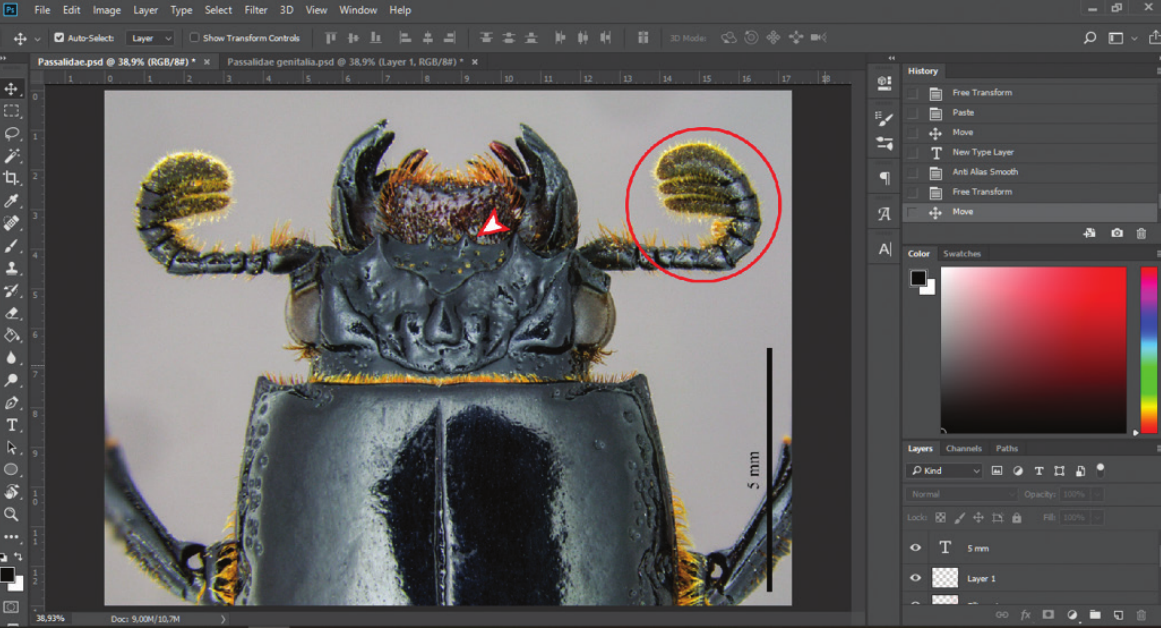
Figure 25. Image containing evidence elements and scale bar with